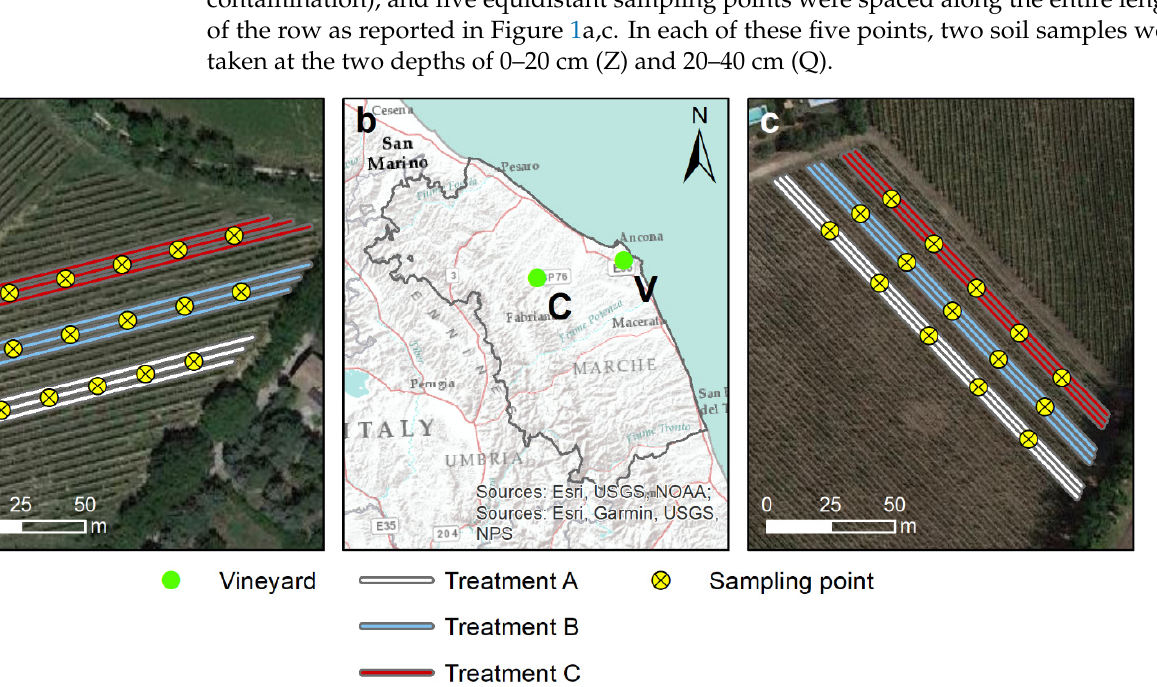
For each plot consisting of three contiguous rows and relating to one of the three theses previously indicated (A, B, and C), the central row was selected (to avoid drift contamination), and five equidistant sampling points were spaced along the entire length of the row as reported in Figure 1a,c. In each of these five points, two soil samples were taken at the two depths of 0–20 cm (Z) and 20–40 cm (Q).